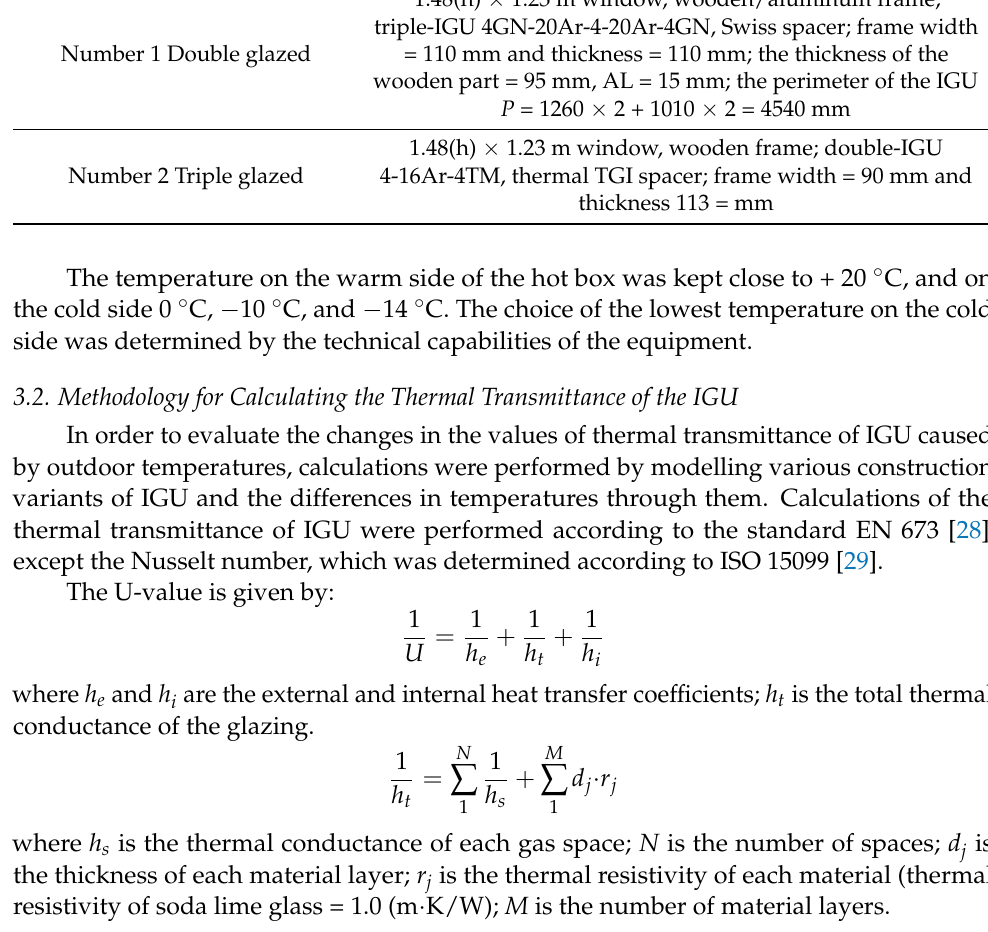
Number 1 Double